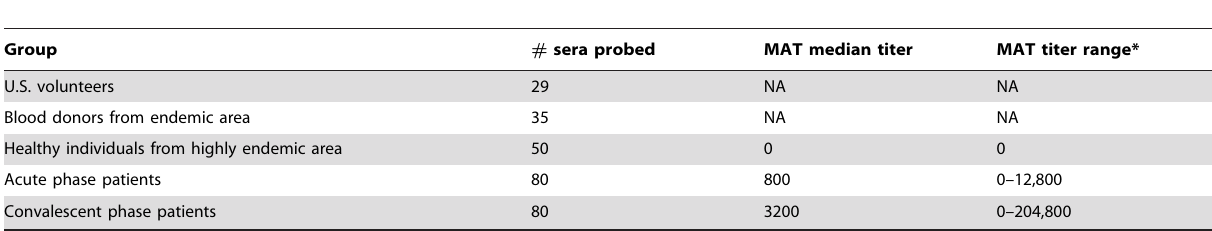
Table 1. Sera collection used in this